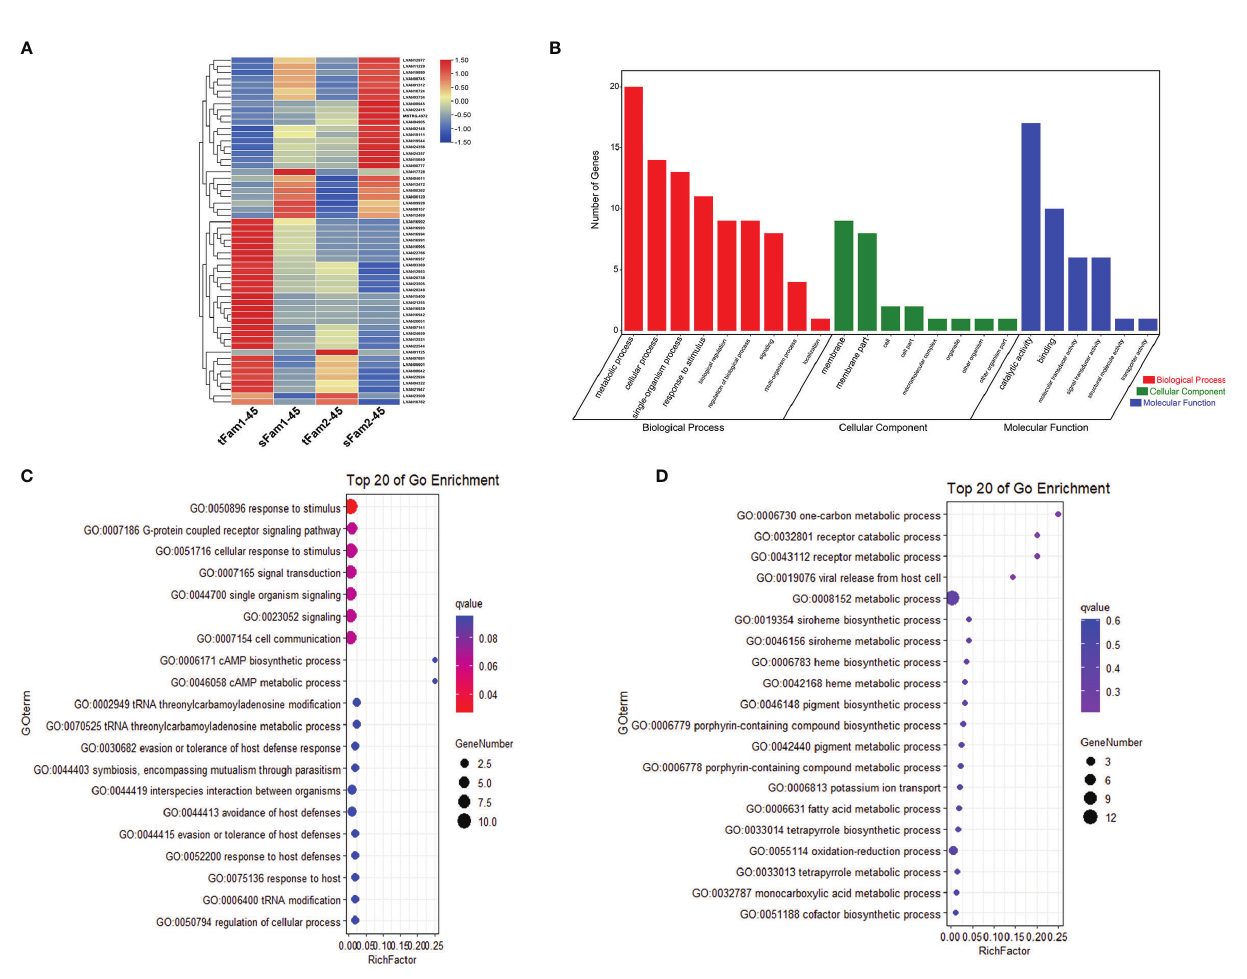
FIGURE 2 | DEGs between high-salinity tolerant families and susceptible families under high-salinity conditions in Litopenaeus vannamei . (A) Gene expression heatmap of DEGs. (B) GO enrichment analysis of DEGs. (C) Top 20 GO terms enriched in the categories of biological process for DEGs upregulated in tolerant families, the point color shows different Q values as indicated on the right, and red color represents the signi fi cant enriched GO term (Q < 0.05). (D) Top 20 GO terms enriched in the categories of biological process for DEGs upregulated in susceptible families; the point color shows different Q values as indicated on the right. DEGs, differentially expressed genes; GO, Gene